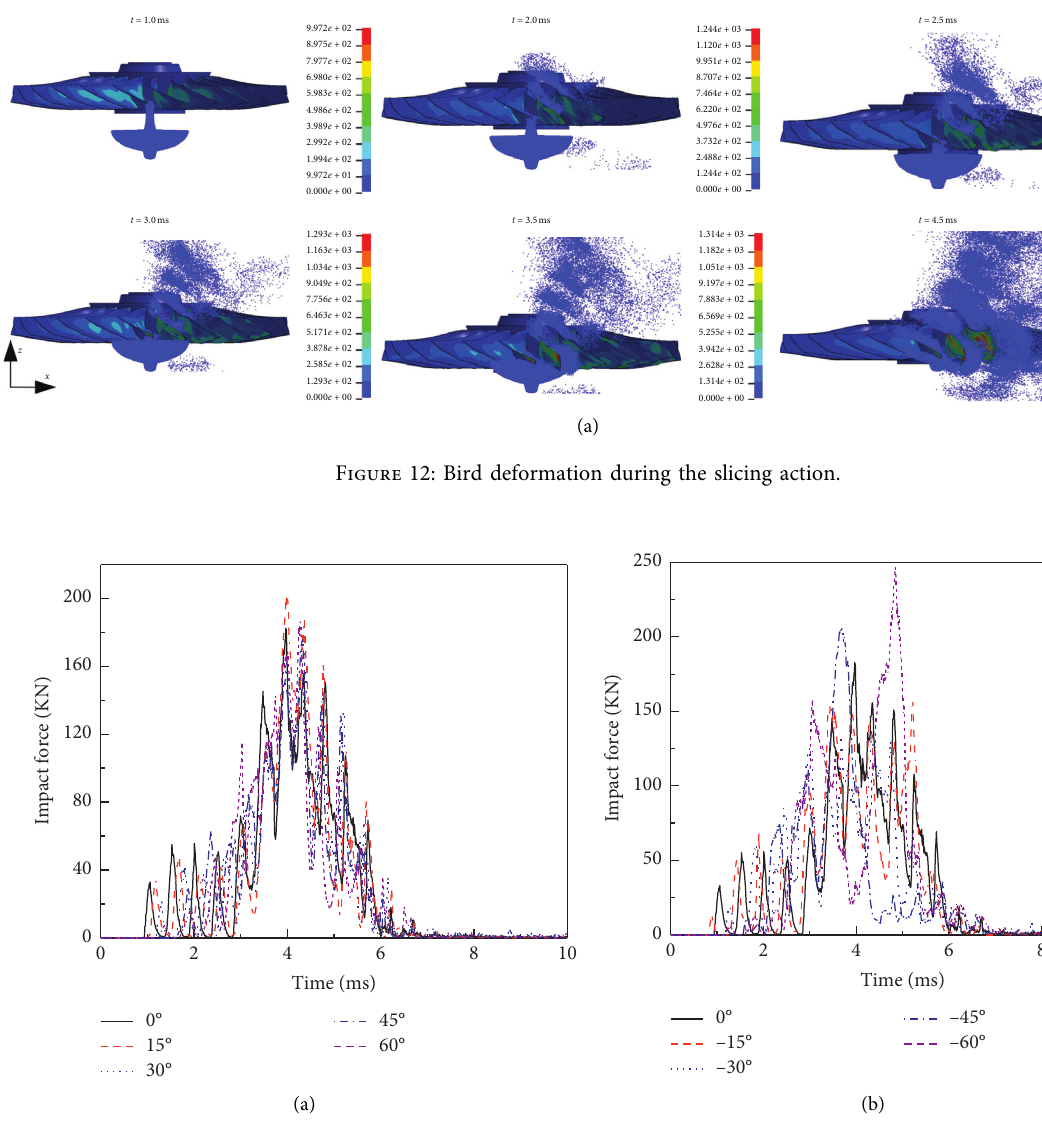
Figure 13: Yaw angle effect on impact loading history. (a) Positive yaw angle α . (b) Negative yaw angle α